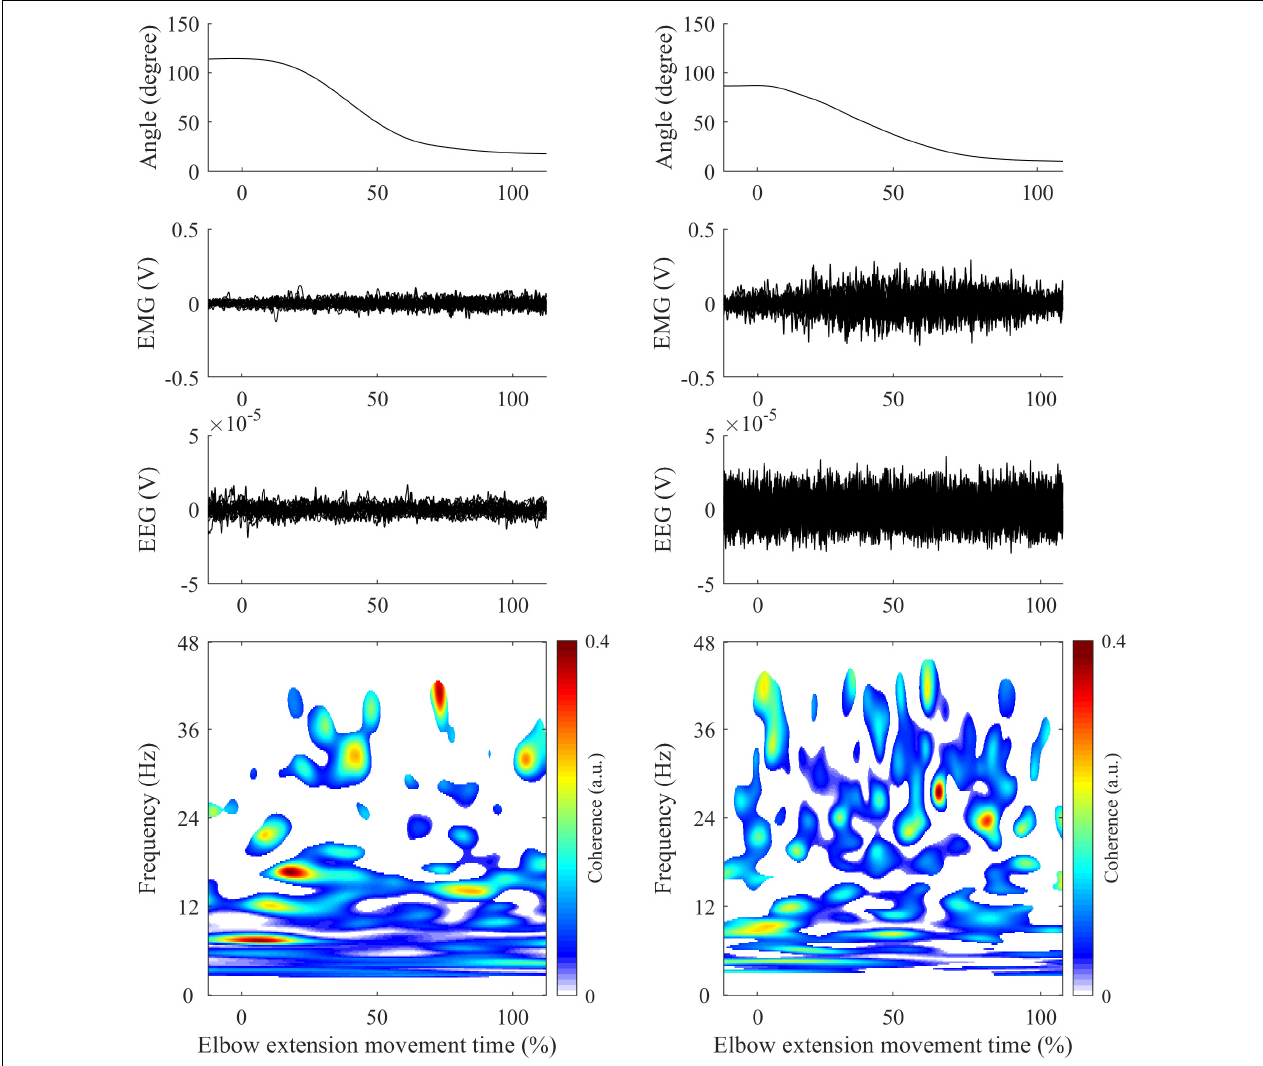
FIGURE 1 | Illustration of typical recordings obtained in control (left panels) and patient (right panels) during elbow extension movement. First row: Elbow joint kinematics. Second row: Mean EMG signals from Triceps Brachii. Third row: Mean EEG signals from C3/C4 electrodes (depending on the studied arm). Fourth row: CMC computed between EMG (Triceps Brachii) and EEG signals following steps described in methods. All-time series are represented in percent of elbow